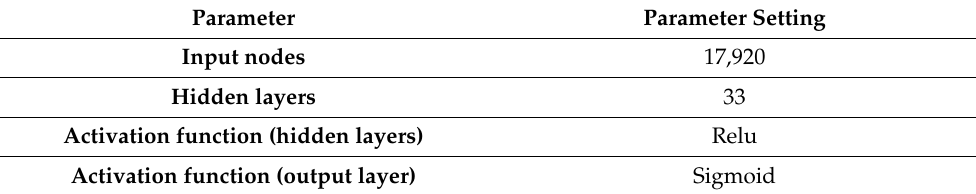
Table 7. DL parameter